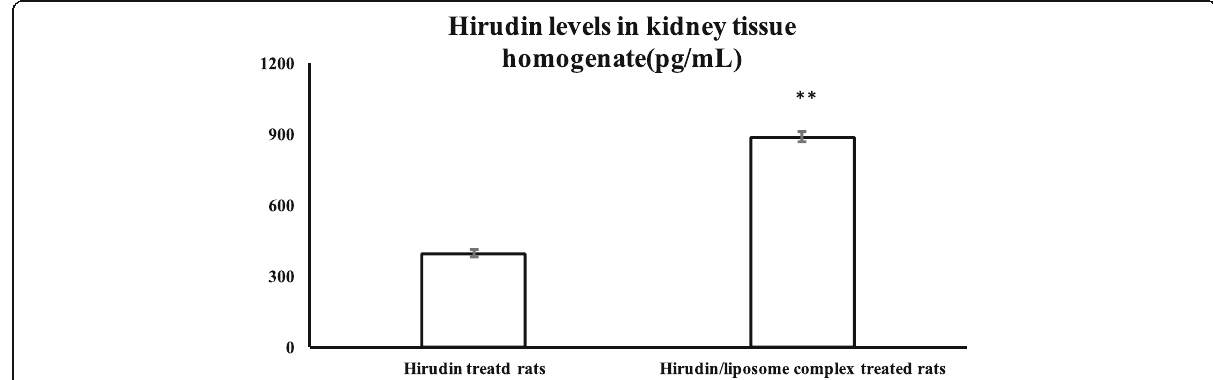
Fig. 4 Six hours after injection of the hirudin/liposome complex, hirudin levels in the kidneys were significantly higher in hirudin/liposome complex-treated rats compared with the hirudin-treated rats. Hirudin treated rats ( n = 10); Hirudin/liposome complex treated rats ( n = 10). **: P <0.01 compared with hirudin-treated rats